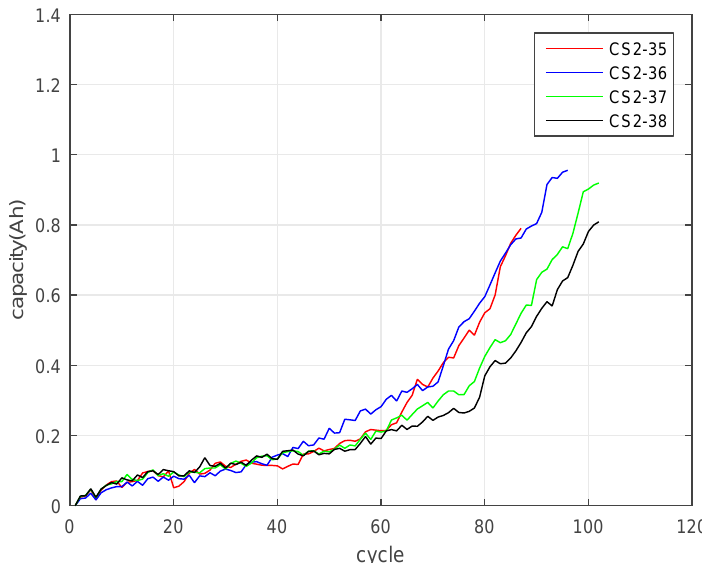
Figure 1. Degradation paths of a lithium-ion battery (LiB).